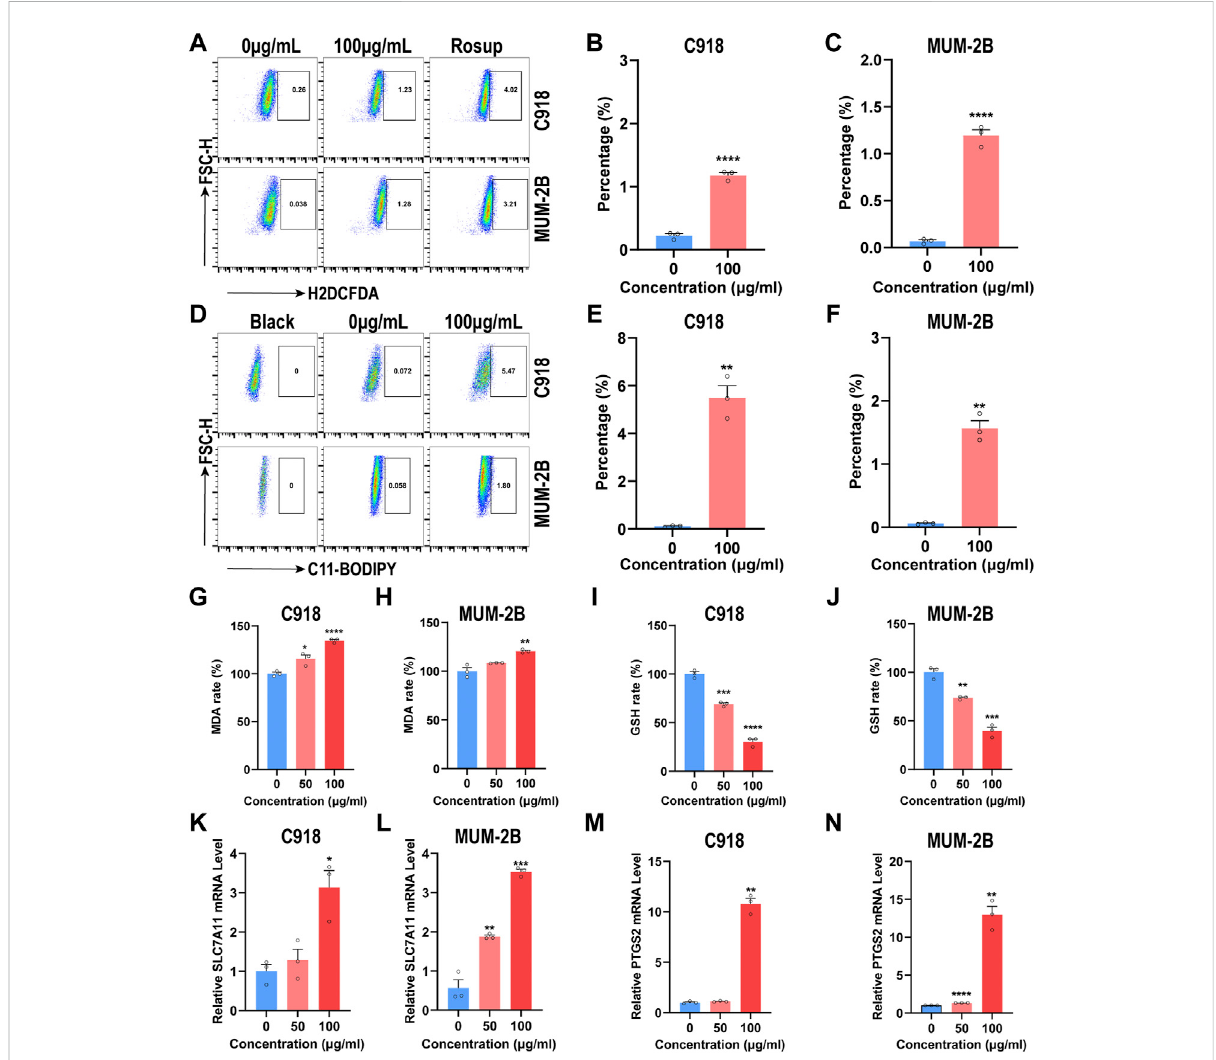
FIGURE 5 NMQDs-Ti 3 C 2 Tx causes ROS accumulation and induces ferroptosis in UM cells (A,B and C) The ROS levels in UM cells incubated with different concentrations of NMQDs-Ti 3 C 2 Tx were determined by fl ow cytometry coupled with H2DCFDA staining. Rosup, a ROS inducer, was used as the positive control (n = 3, **** p < 0.0001, compared with the control group) (D,E and F) The levels of lipid peroxides in UM cells treated with different concentrations of NMQDs-Ti 3 C 2 Tx were determined by fl ow cytometry coupled with C11-BODIPY staining (n = 3, ** p < 0.005) (G and H) The MDA levels of UM cells after 6 h of incubation with 100 μ g ml − 1 of NMQDs-Ti 3 C 2 Tx (n = 3; * p < 0.05, ** p < 0.005, **** p < 0.0001) (I and J) The GSH levels of UM cells after 6 h of incubation with 100 μ g ml − 1 of NMQDs-Ti 3 C 2 Tx (n = 3; ** p < 0.005, *** p < 0.0005, **** p < 0.0001) (K,L) The SLC7A11 RNA levels of UM cells after 6 h of stimulation with NMQDs-Ti 3 C 2 Tx. GAPDH was used as a loading control (n = 3; * p < 0.05, ** p <